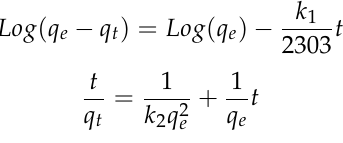
Table 1. Some features of the organic molecules investigated.